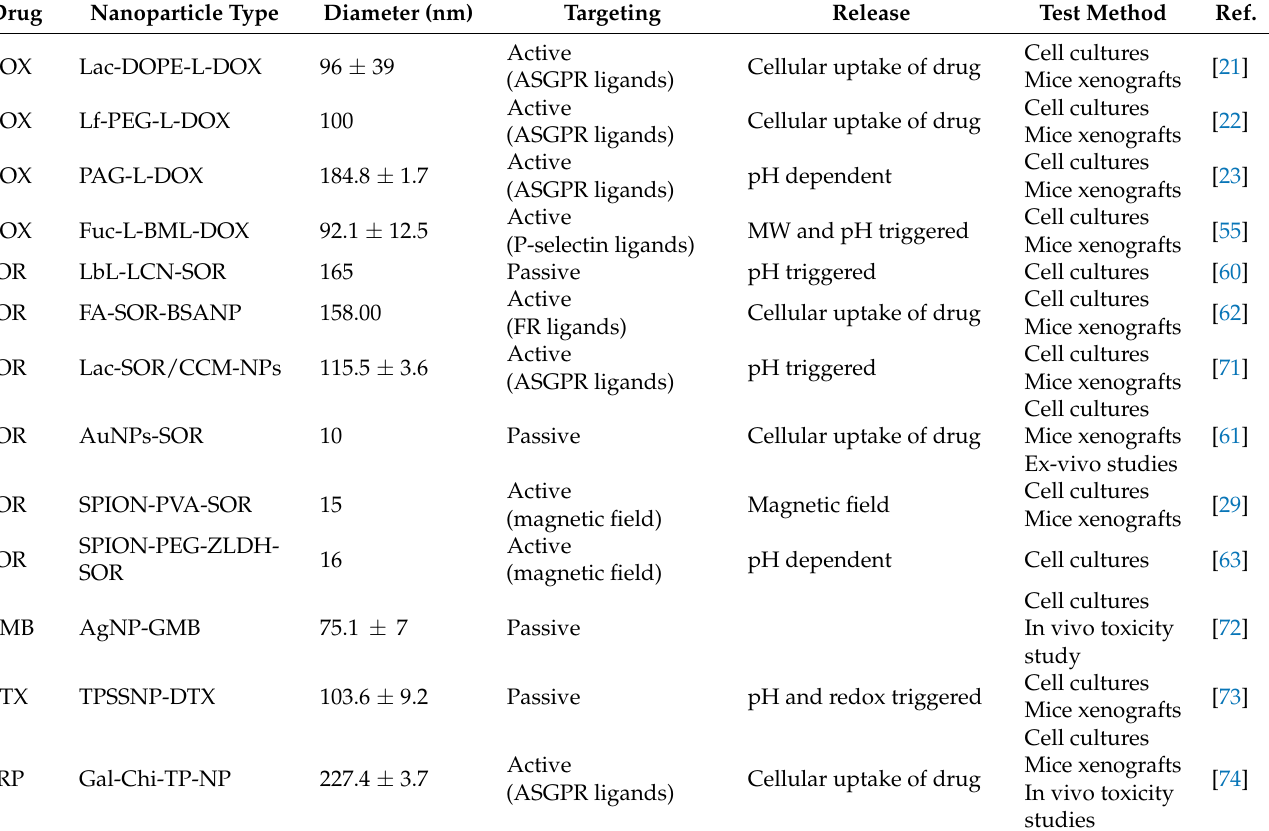
Table 2. Comparison of different targeted delivery strategies for the treatment of